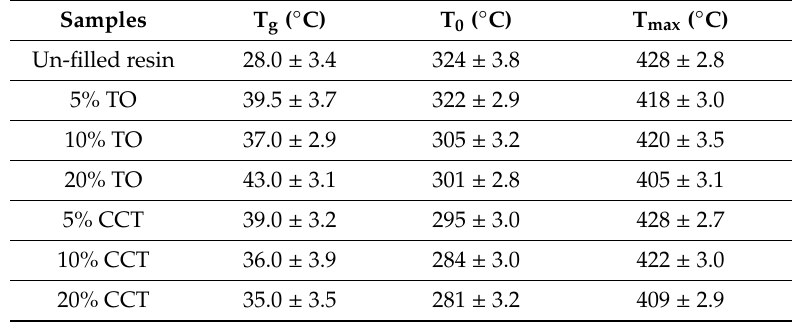
Figure 7. DSC thermograms of 3D printed ( a ) TO composite, ( b ) CCT composite and TGA curves for the 3DP ( c ) TO composite, ( d ) CCT composite. Table 1. Glass transition temperature T g , onset degradation T 0 , and maximum degradation temperature T max obtained in the 3D-printed